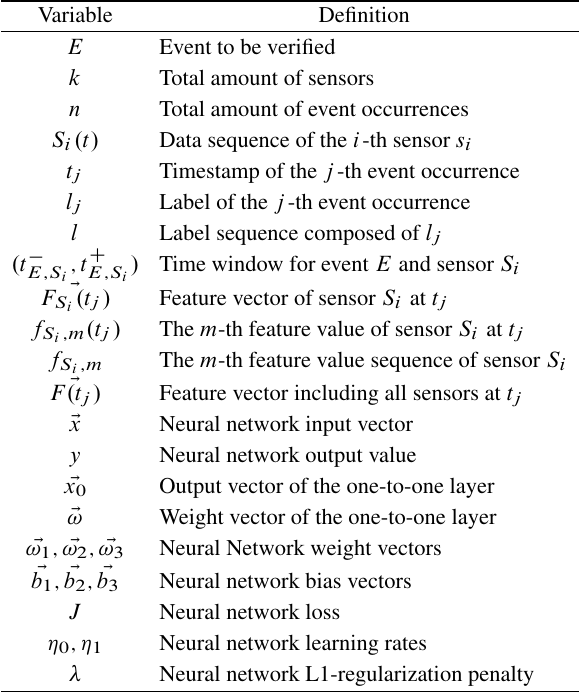
Table 2 List of the major